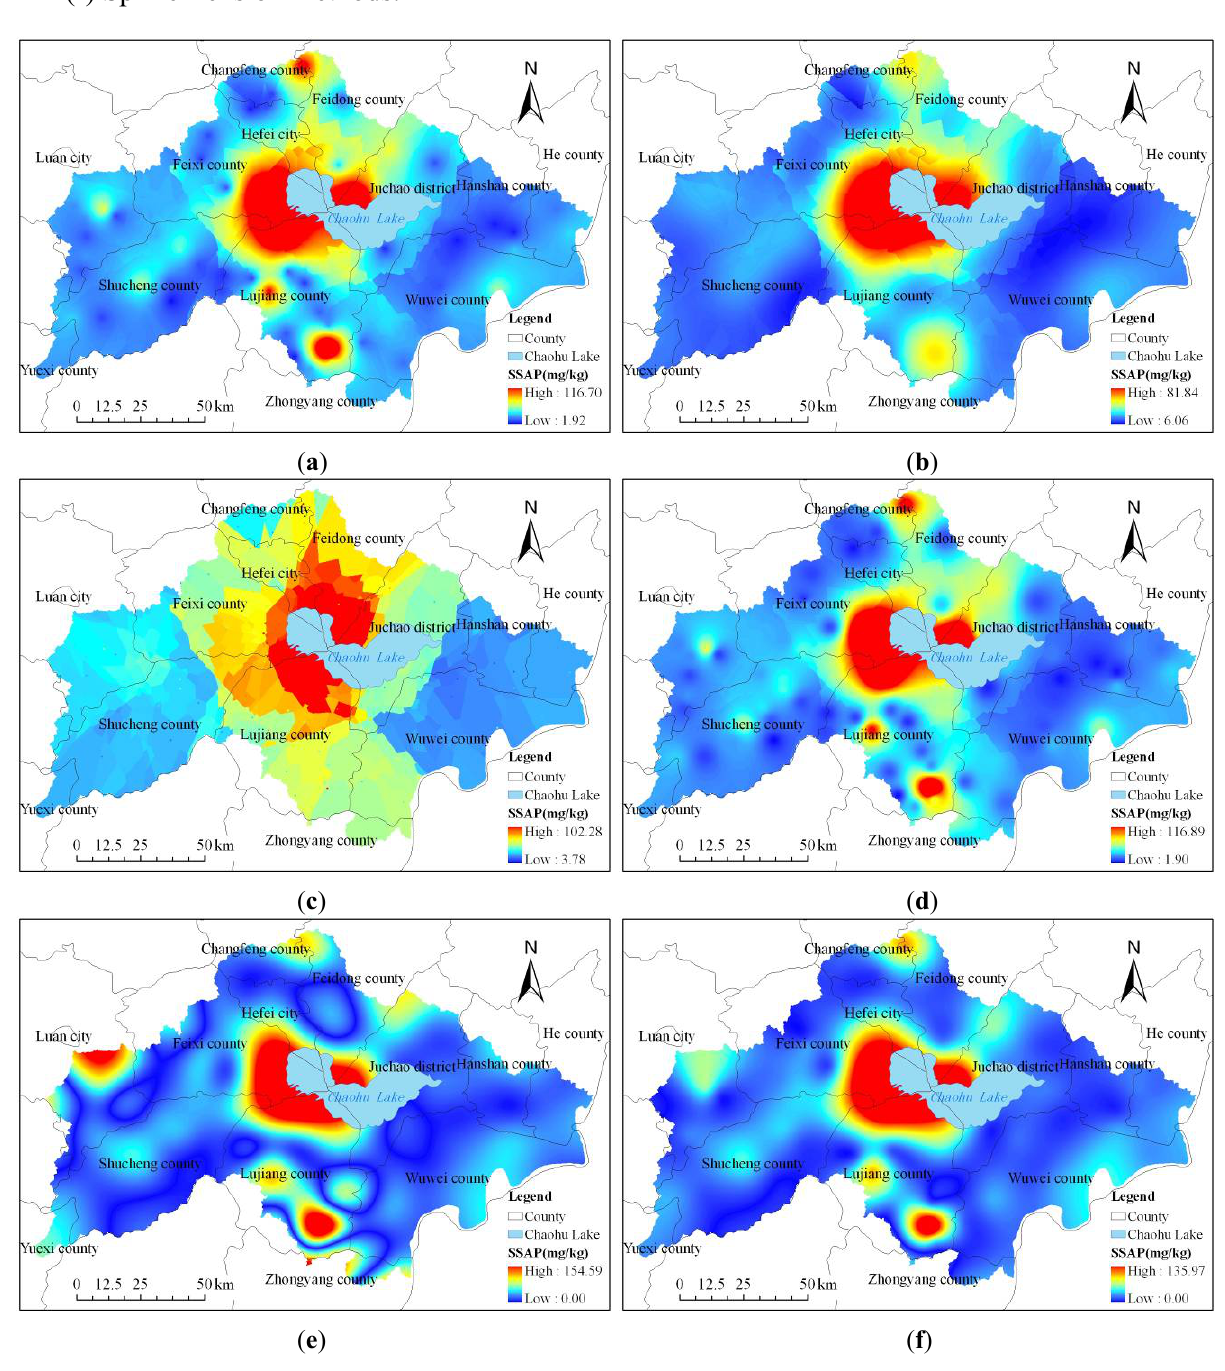
Figure 2. Predicted soil available phosphorus using ( a ) Kriging Ordinary Exponential ( b ) Kriging Ordinary Gaussian ( c ) Kriging Ordinary Spherical ( d ) IDW ( e ) Spline Regularized ( f ) Spline Tension methods.